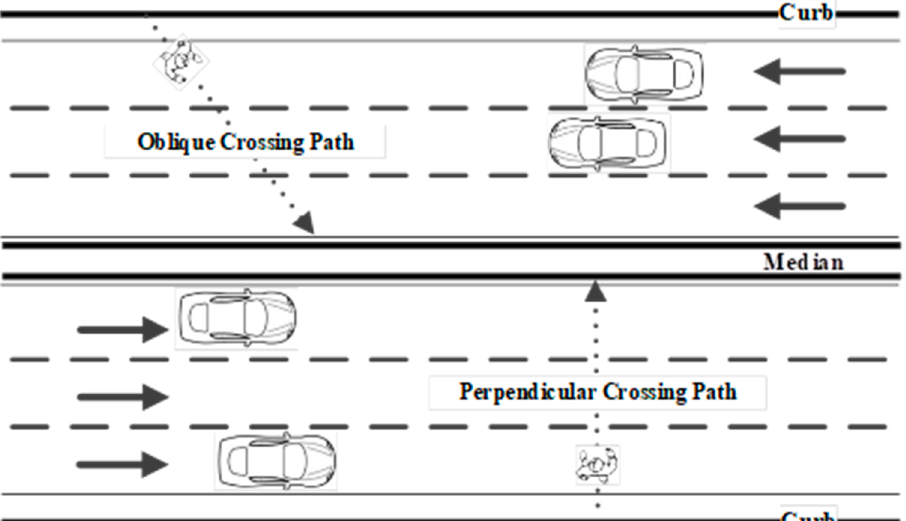
Figure 1. Layout of the study setup.